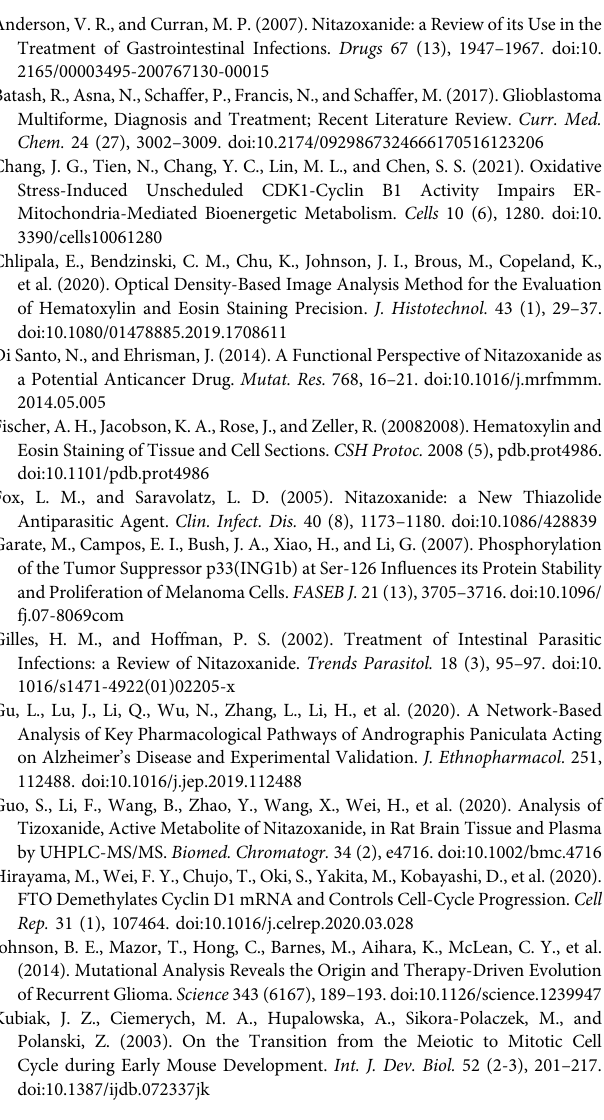
CDK5, and CDK9. It is being evaluated in clinical trials for various cancer indications. Supplementary Figure S2 | Analysis of blood biochemical parameters in nude miceafterTIZadministrationTheresultsofRBC (A) ,ALT (C) ,AST (D) ,andCREA (E) showedthatRedblood cells and hepatic and renal function inmice have no obvious changesbetweenthevehicleandTIZ-treatedgroups.Thereasonfortheincreasein white blood cells might be that an in fl ammatory response was stimulated during TIZ administration (B) . Data are presented as the mean ± SD ( n = 5, * p < 0.05, ** p < 0.01, # p <